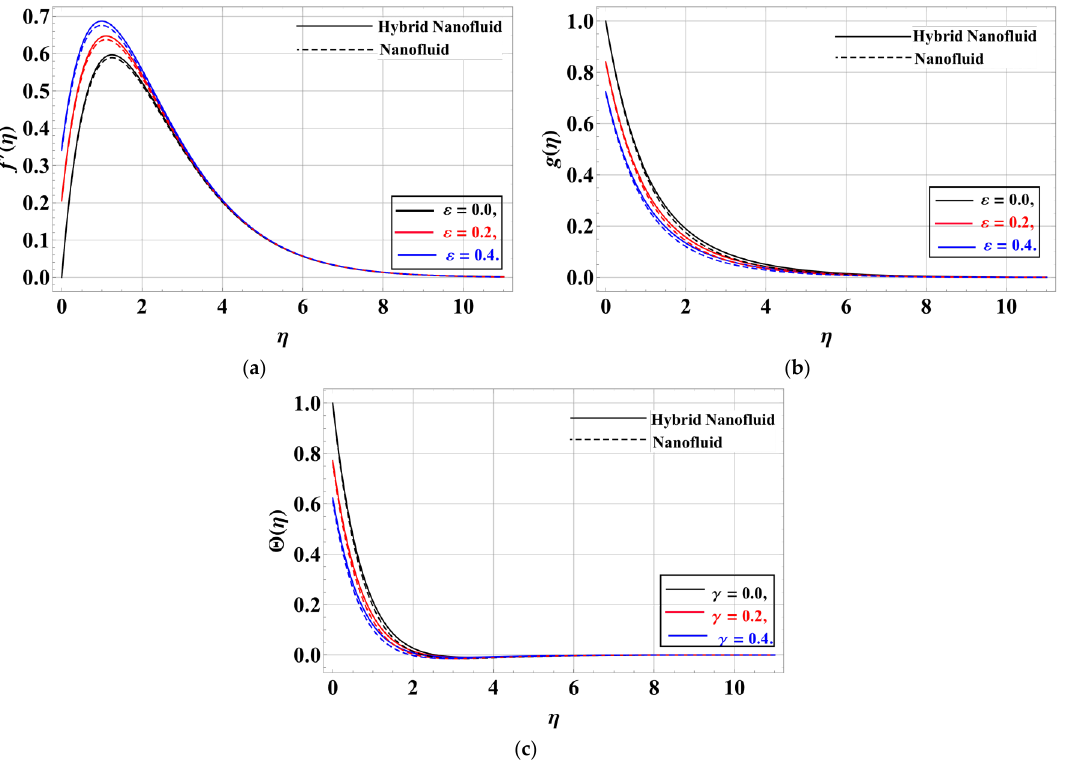
Figure 2. Variations in f (cid:48) ( η ) , g ( η ) & Θ ( η ) against ε & γ . ( a ) Variations in f (cid:48) ( η ) against ε ( b ) Variations in g ( η ) against ε . ( c ) Variations in Θ ( η ) against γ .